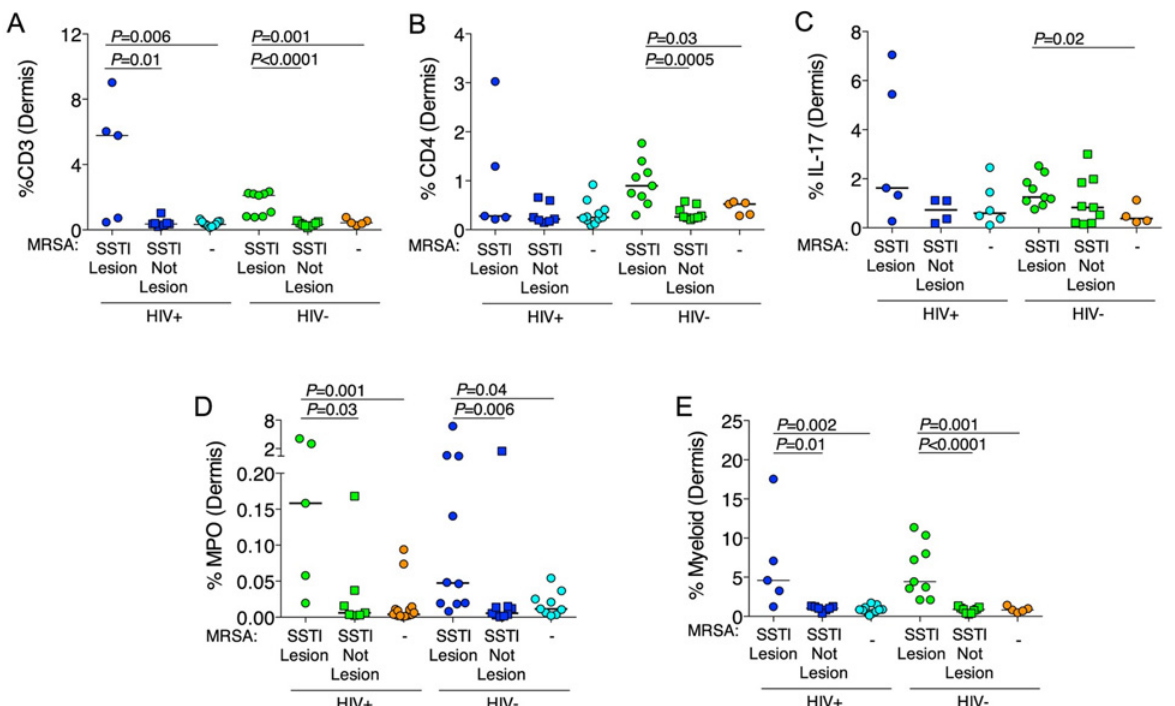
Fig 3. Histological evaluation of skin biopsies. Skin biopsies were obtained from MRSA SSTI participants at the infection site (SSTI lesion) or a distant site (SSTI Not Lesion), or MRSA-negative participants (-). (A) Abundance of CD3. (B) Abundance of CD4. (C) Abundance of IL-17. (D) Abundance of neutrophils (myeloperoxidase + [MPO]). (E) Abundance of macrophage/myeloid cells (CD68 + and/or CD163 + ). P -values were calculated using the Mann- Whitney U test.